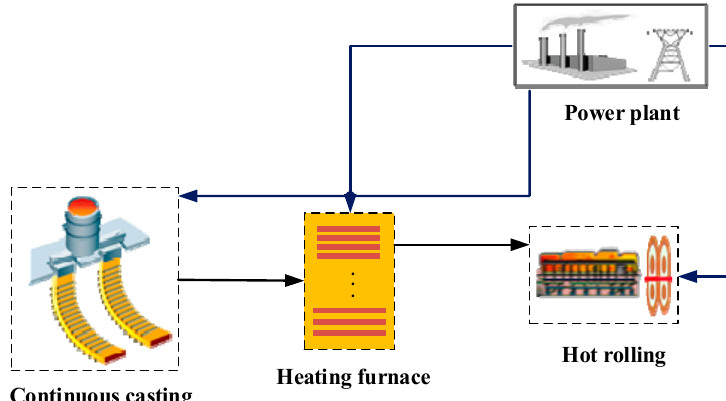
Figure 1. Flow chart of the rolling process.